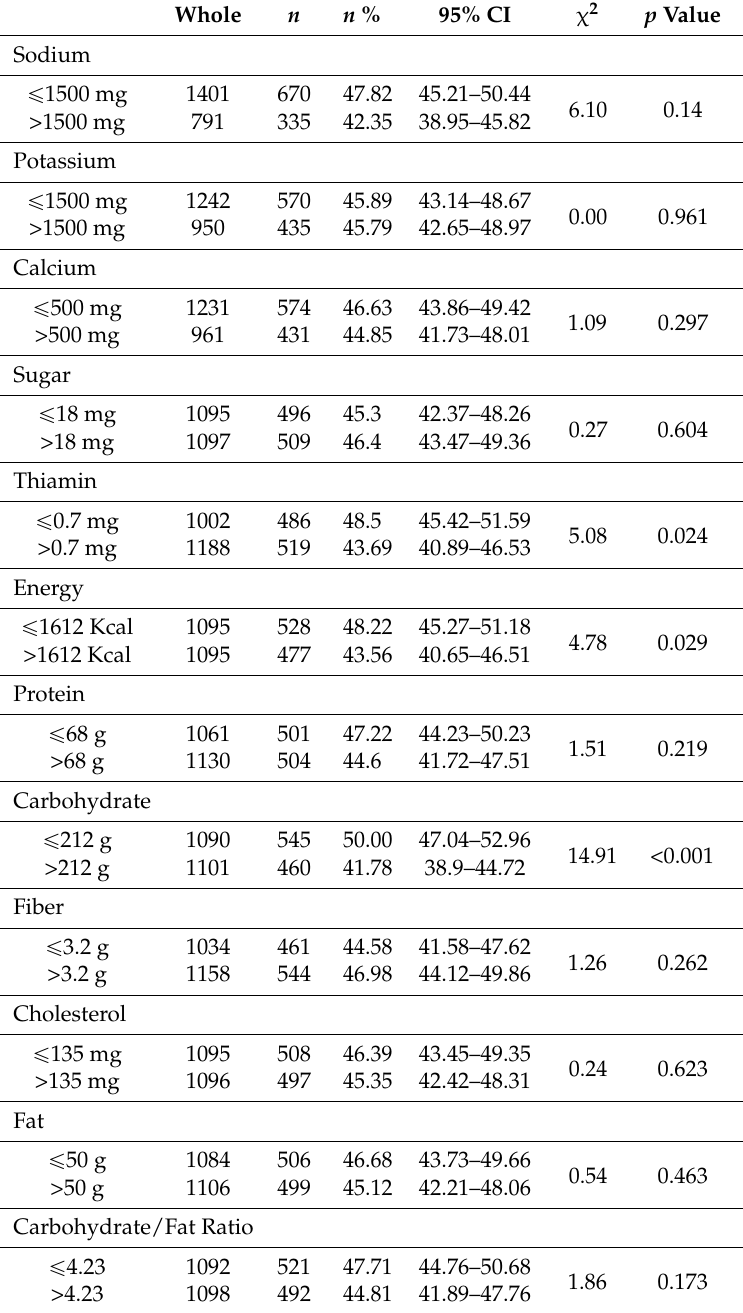
Table 3. Prevalence of hypertension and associations with nutritional